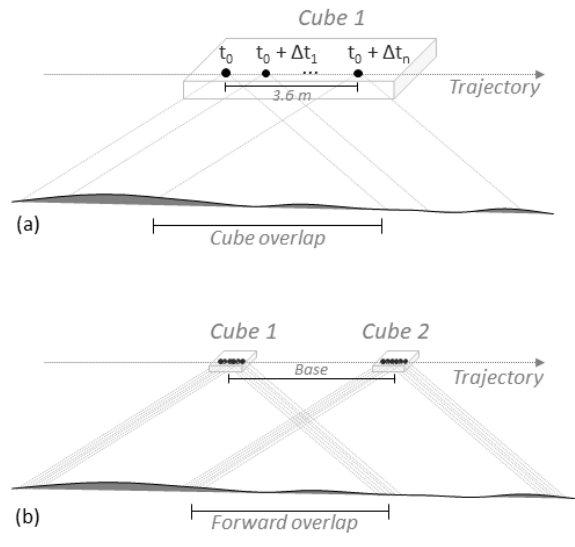
Figure 1. Band displacement when collecting images with the platform in movement in the flight direction. (a) Band displacement as a function of time in a cube. (b) Relationship between